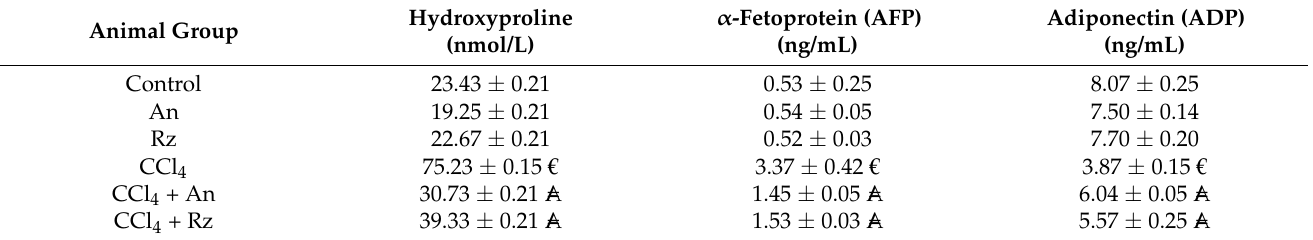
Table 6. Ameliorative effects of An or Rz administration on hydroxyproline, alpha-fetoprotein (AFP), and adiponectin (ADP) in different experimental groups during CCl 4 -induced hepatotoxicity.